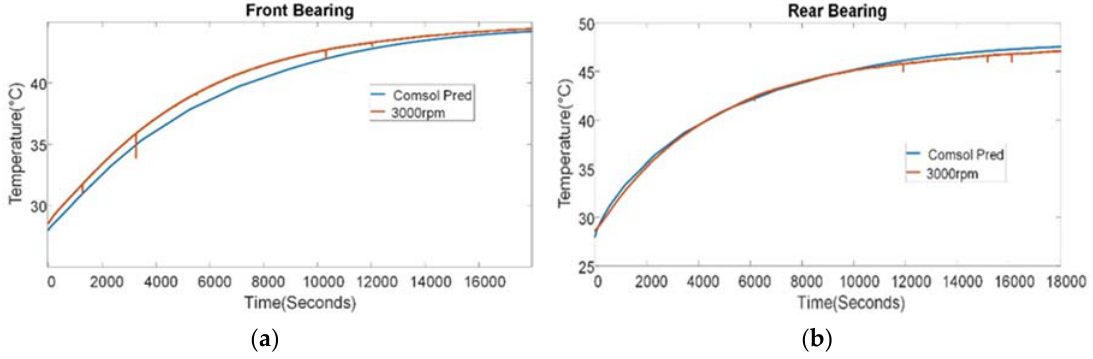
Figure 4. ( a ) Plot of front-bearing temperature rise from a Comsol analysis compared to actual measurements. ( b ) Plot of rear-bearing temperature rise from a Comsol analysis compared to actual measurements [20].